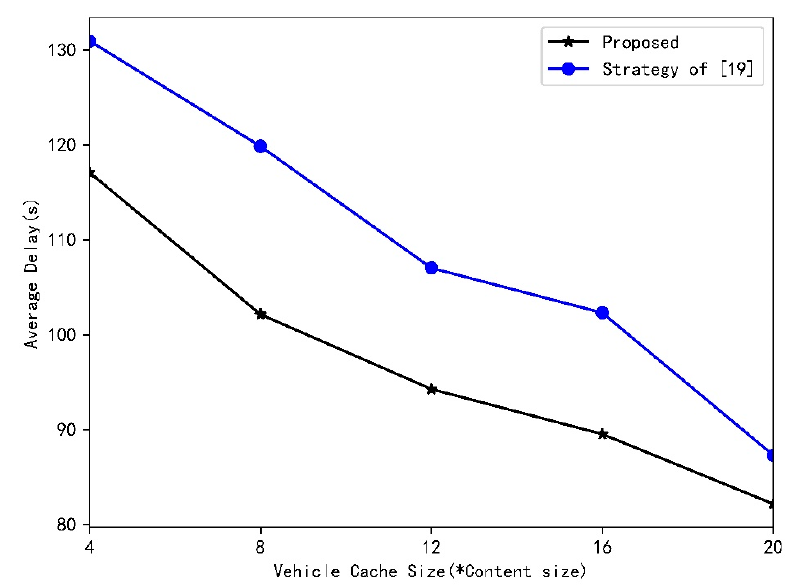
Figure 9. The relationship between the Average Delay and vehicle caching size.